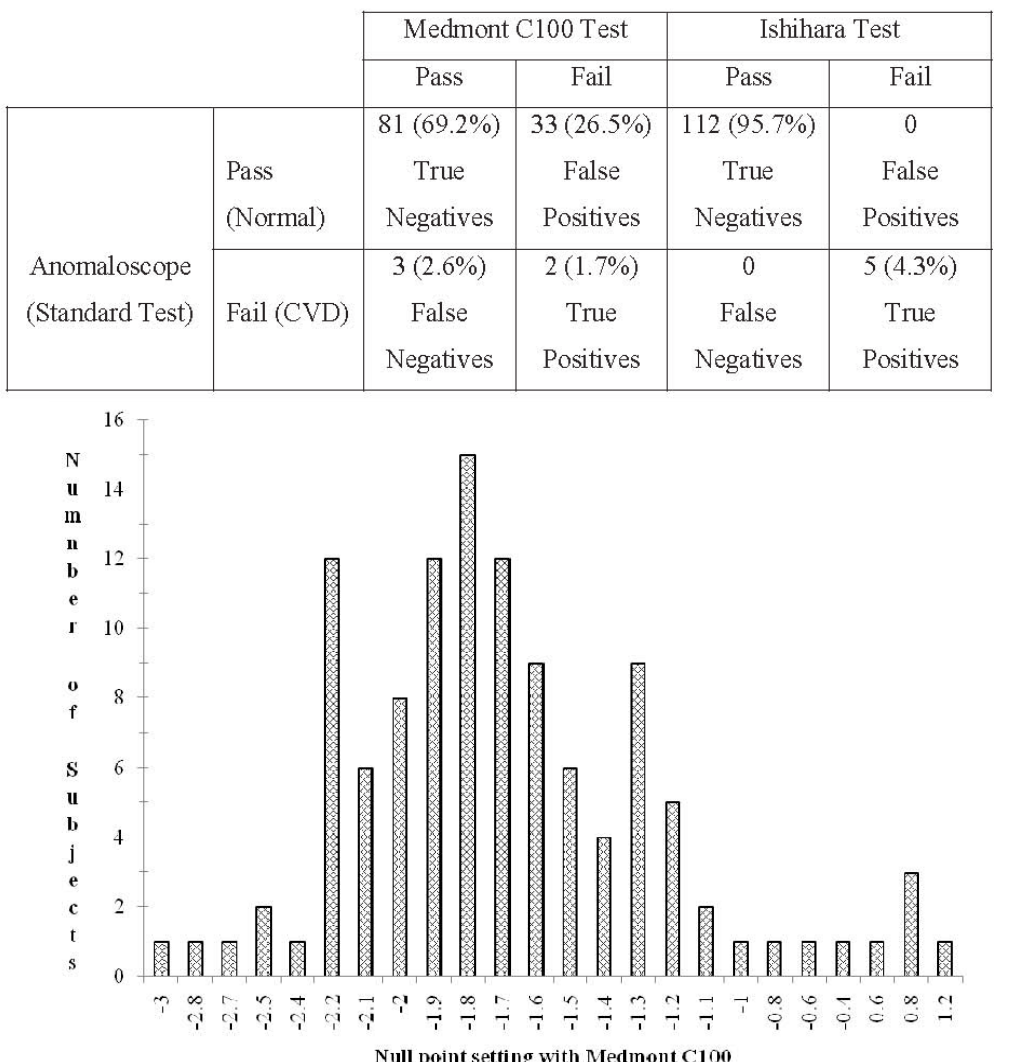
Table 2. Differences in terms of pass/fail responses between Medmont C100 and Ishihara tests compared to Anomaloscope test results. Percentages indicate number of cases/amount of pass/fail responses out of the 117 subjects.